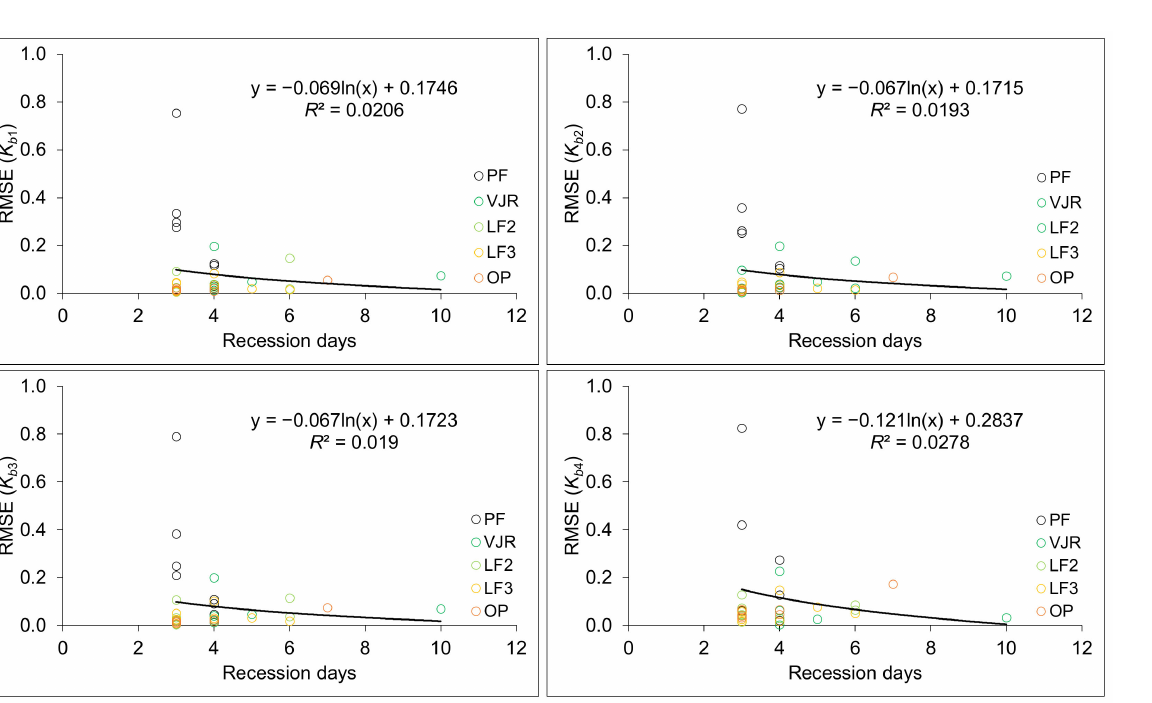
Figure 3. Root mean squared error (RMSE) versus recession